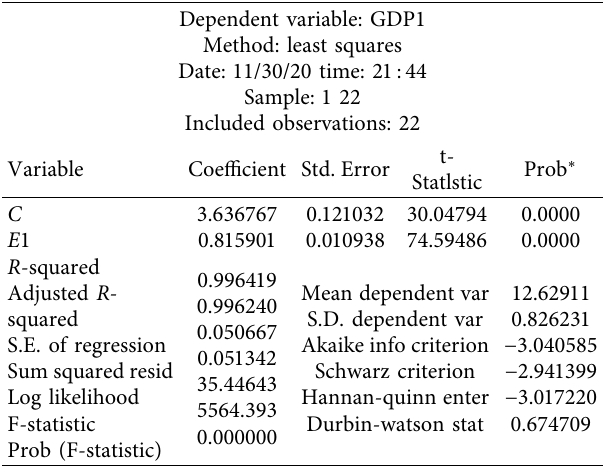
Table 5: Regression results of China’s GDP and fiscal expenditure data from 1998 to 2019.